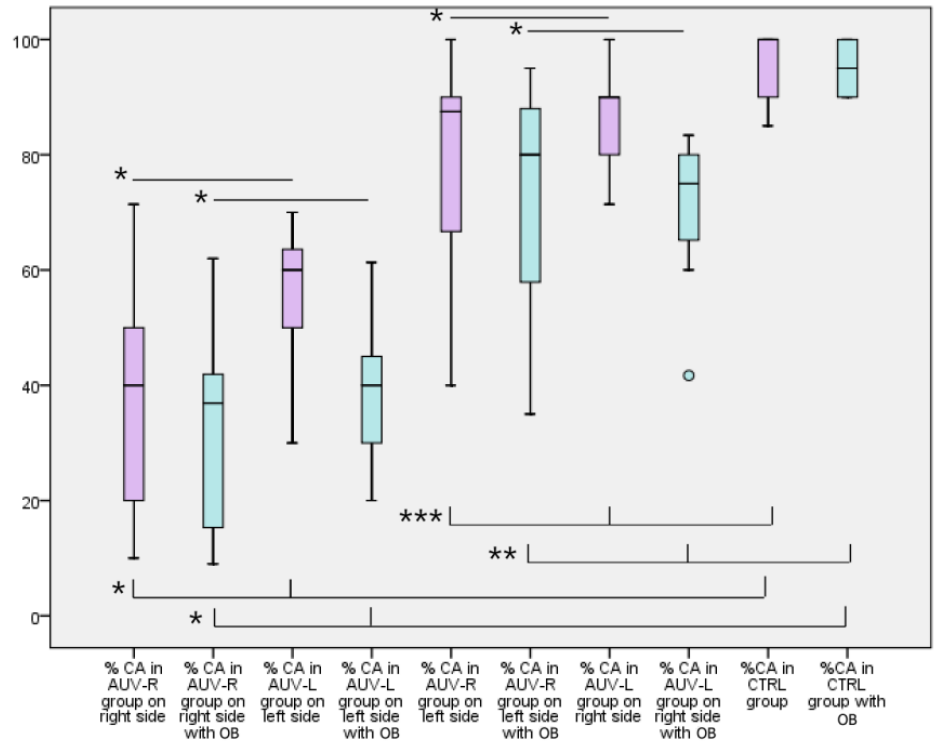
Figure 2. Boxplot showing the percentages of correct answers in the AUV group on the right and left sides without and with the optokinetic background (OB) and the %CA in the control group without and with OB. A significant difference was found between %CA values on the deficit side and the normal side in the AUV-L and AUV-R groups, both without OB ( p < 0.001 and p < 0.001 [*], respectively) and with OB ( p < 0.001 and p < 0.001 [*], respectively). A statistically significant difference was also found in the %CA values in AUV-R and AUV-L on the normal side and on the deficit side and the %CA values in the CTRL group without OB ( p < 0.05, p < 0.05 [***] and p < 0.001, p < 0.001 [*], respectively) and with OB ( p < 0.01, p < 0.01 [**] and p < 0.001, p < 0.001 [*], respectively). The mean difference in the errors with and without the optokinetic background ( ∆ OB) in the VM group was 18.36. A total of 58% of patients with VM showed a significant decrease in the %CA with the OB, considered as a %CA decrease greater than 2SD of the means of the %CA. In the AUV group, this percentage was 36%, meanwhile in the control group that was limited to 7%. ∆ OB value in the CTRL group was 2.15. Finally, ∆ OB in